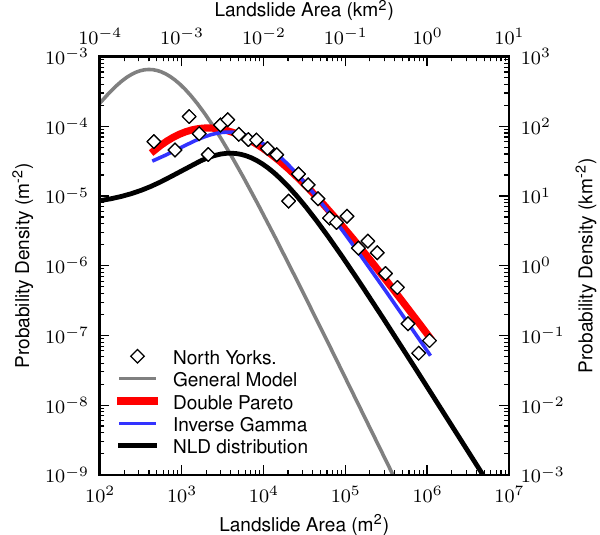
Figure 5. Probability distribution of landslide deposit area for land- slides in North Yorkshire organised into logarithmically spaced bins (open diamonds). Solid black and grey lines show maxi- mum likelihood estimates of a double Pareto function ( α p = 0 . 61; β = 3 . 7; A peak = 927m 2 ) and inverse gamma function ( α g = 0 . 71; r = 9 . 57 × 10 − 3 km 2 ; s = − 1 . 83 × 10 − 3 km 2 ) respectively, dashed grey and black lines show the general distribution proposed by Malamud et al. (2004) and the UK distribution from Fig. 3a, respectively. Note the similarity in shape between the North Yorkshire data set and the UK NLD fit (the vertical o ff set in probability density, is due to a di ff erence in the range of landslide sizes considered and does not indicate relative